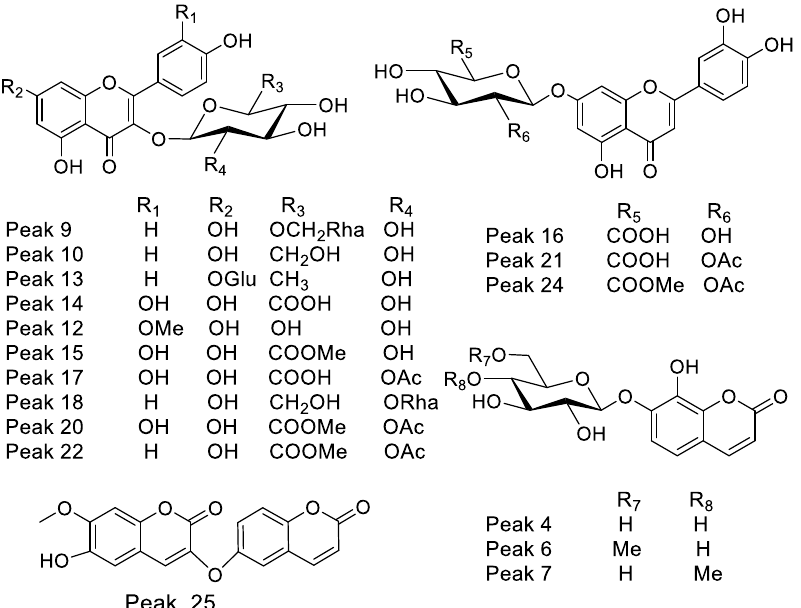
Figure 2. UHPLC chromatograms of Lloime ( a ) TIC, ( b ) UV chromatograms at 280 nm. Table 1. UHPLC-PDA-MS identification of the ethanolic extract from Lloime ( Ovidia pillopillo ).